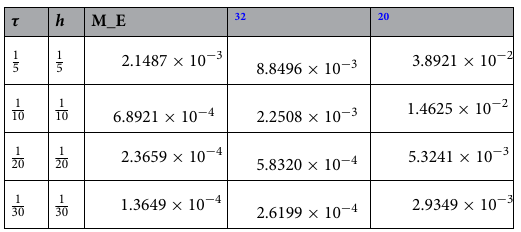
Table 5. Comparison of the proposed scheme Eq. (7) with 32 and 20 for the Example 1, where γ = 0.5 .